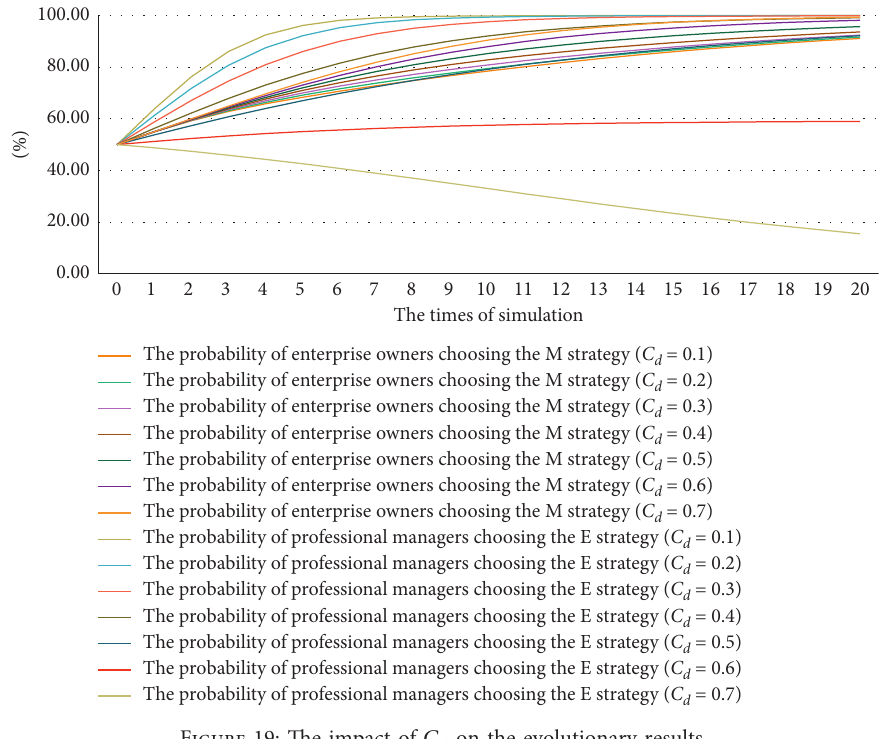
Figure 19: The impact of C d on the evolutionary